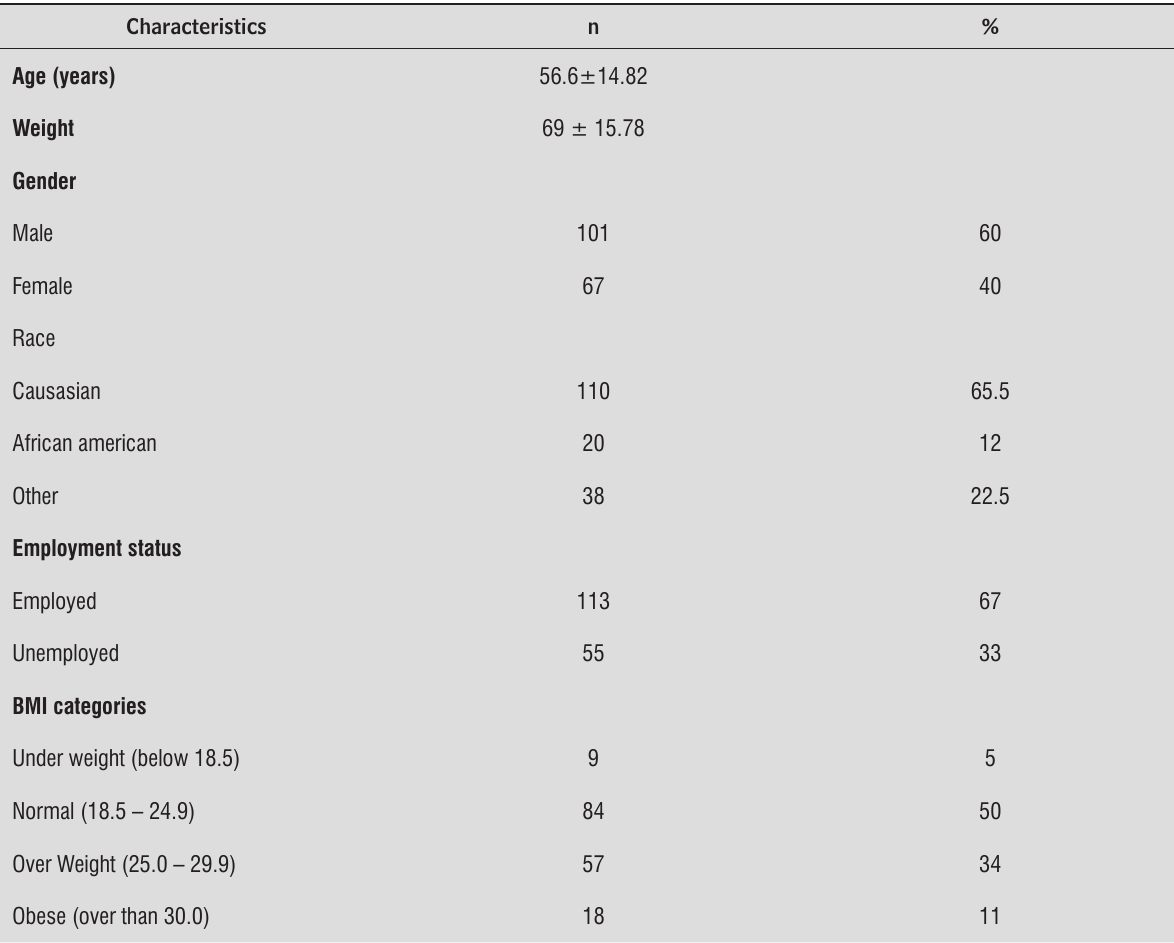
Table 1 - Social and demographic characteristics